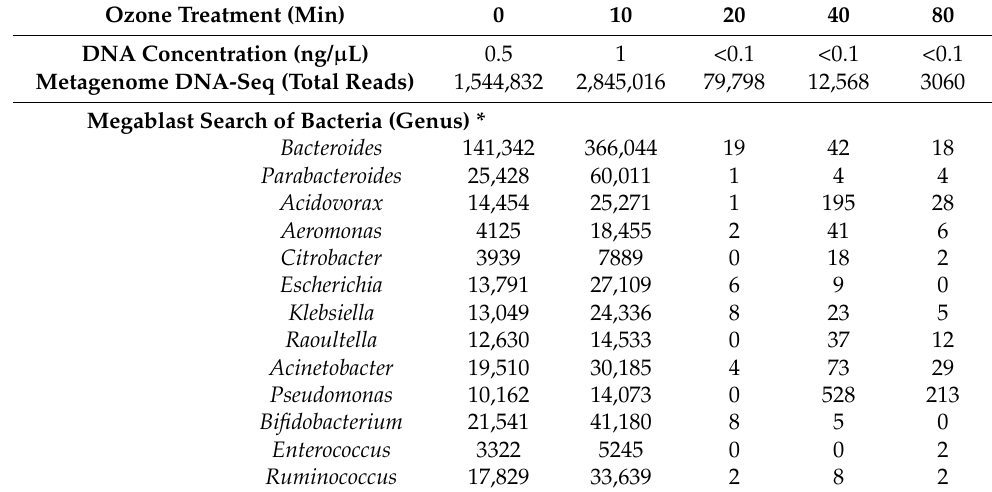
Table 1. Metagenomic DNA-seq analysis of bacteria trapped on a 0.2 µ m filter after ozone treatment.